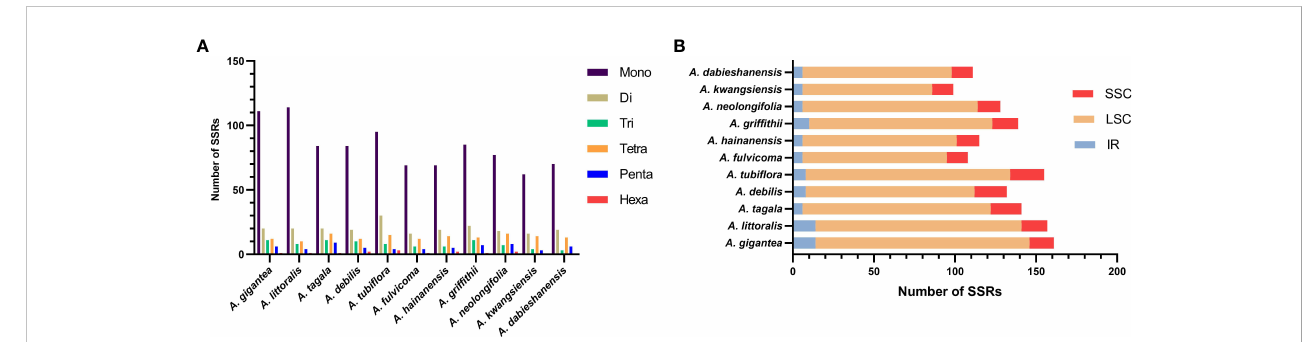
FIGURE 3 Amounts and distribution of SSRs in the chloroplast genome of 11 species of Aristolochia . (A) Amounts of the SSRs; (B) Distribution of